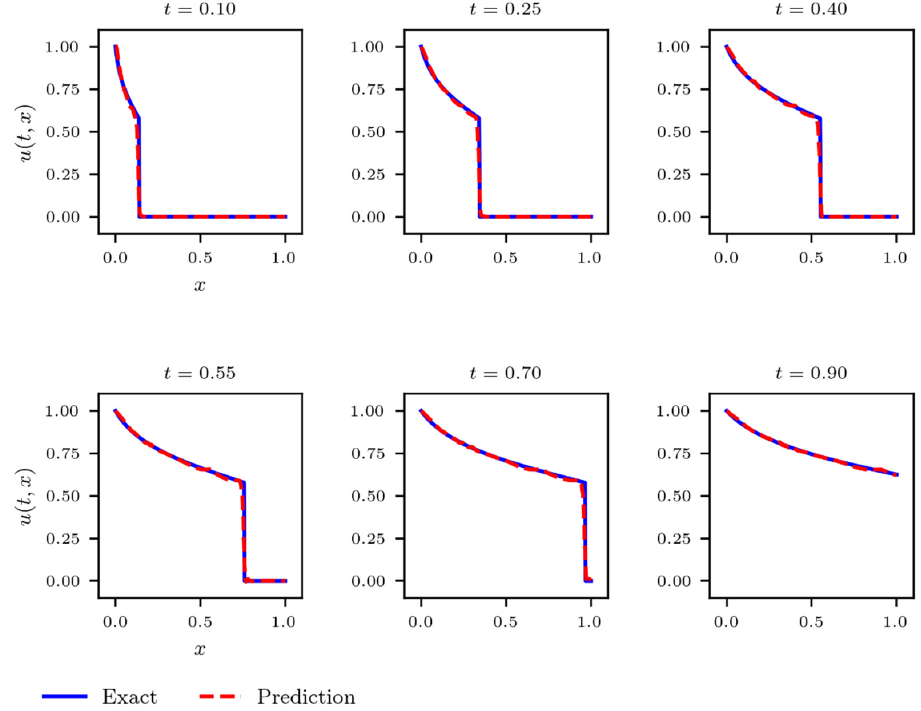
Figure 6. Comparison between composite data-free PINNs solution (dashed line) and the analytical solution (solid line) at six different times.